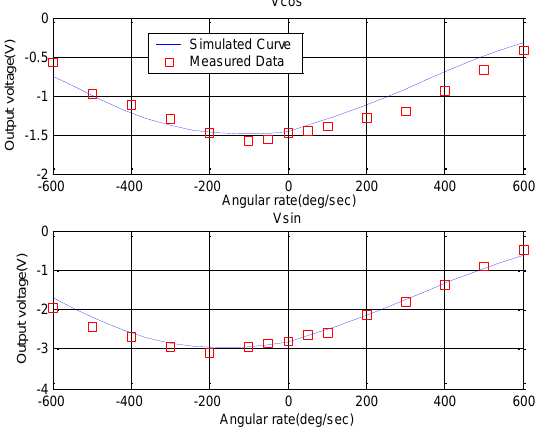
Figure 8. Tow orthogonal components of the output vector versus the angular rate in a dual-phase measurement for device B.